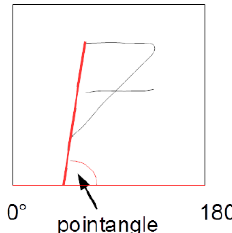
Figure 4. Example of point angle.